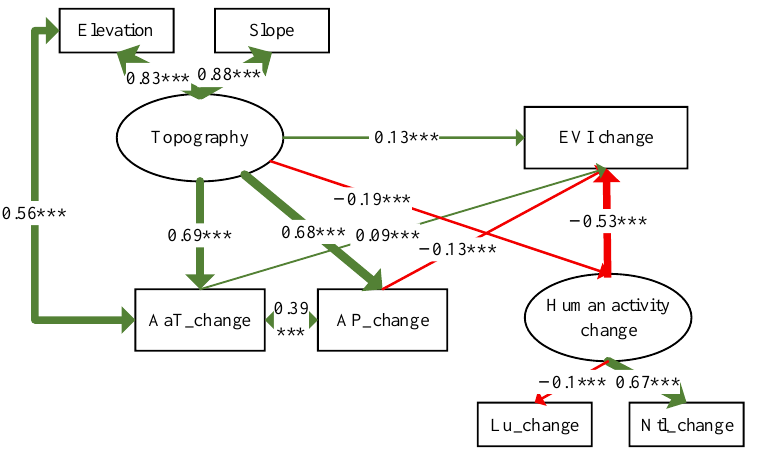
Figure 11. SEM of the relationship between EVI change and its drivers in Anhui Province. Note: AaT_change = annual average temperature change; AP_change = annual precipitation change; Lu_change = Land use change; Ntl_change = nighttime light change. Green lines represent positive effects; red lines represent negative effects. Solid lines represent significant paths. *** Significant at the 99% level.